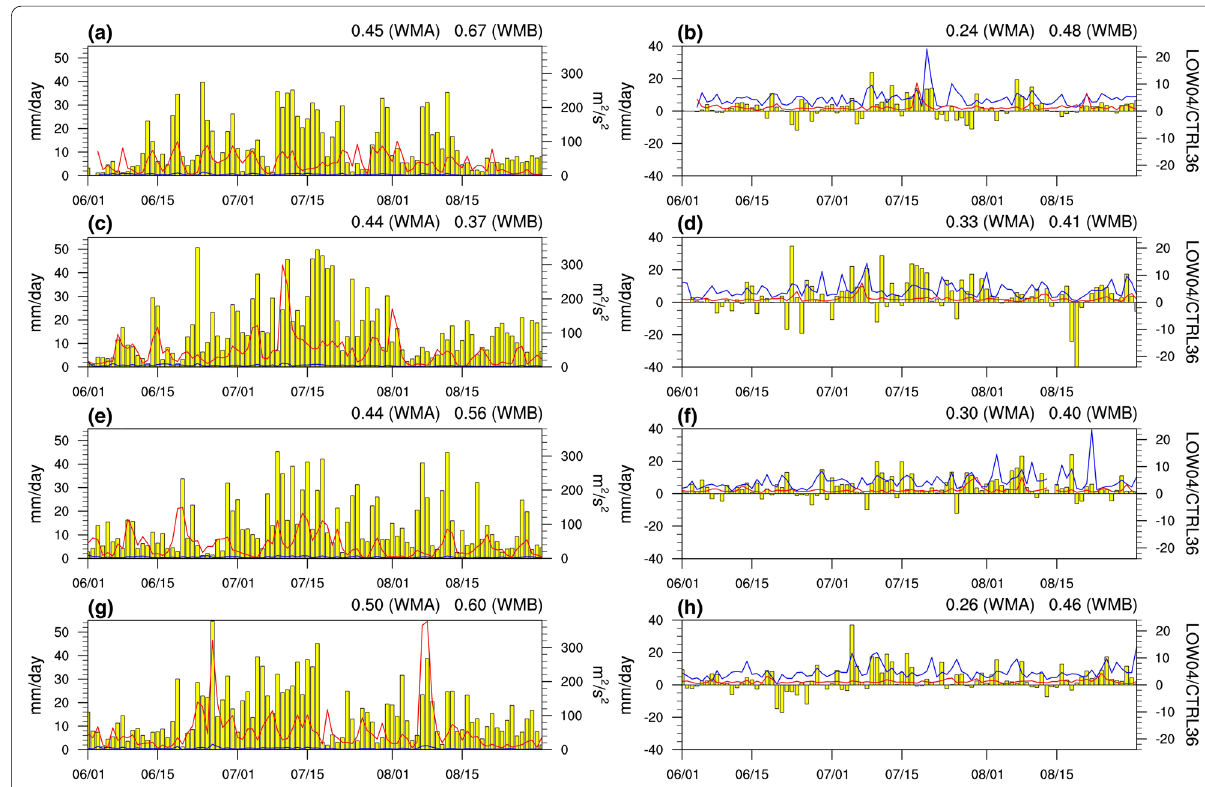
Fig. 5 Area‑averaged daily precipitation and kinetic energy of LOW04 (left) and their changes compared to CTRL36 (right) for a , b 2001, c , d 2006, e , f 2009, and g , h 2011; yellow bar, red line, and blue line represent the precipitation (mm